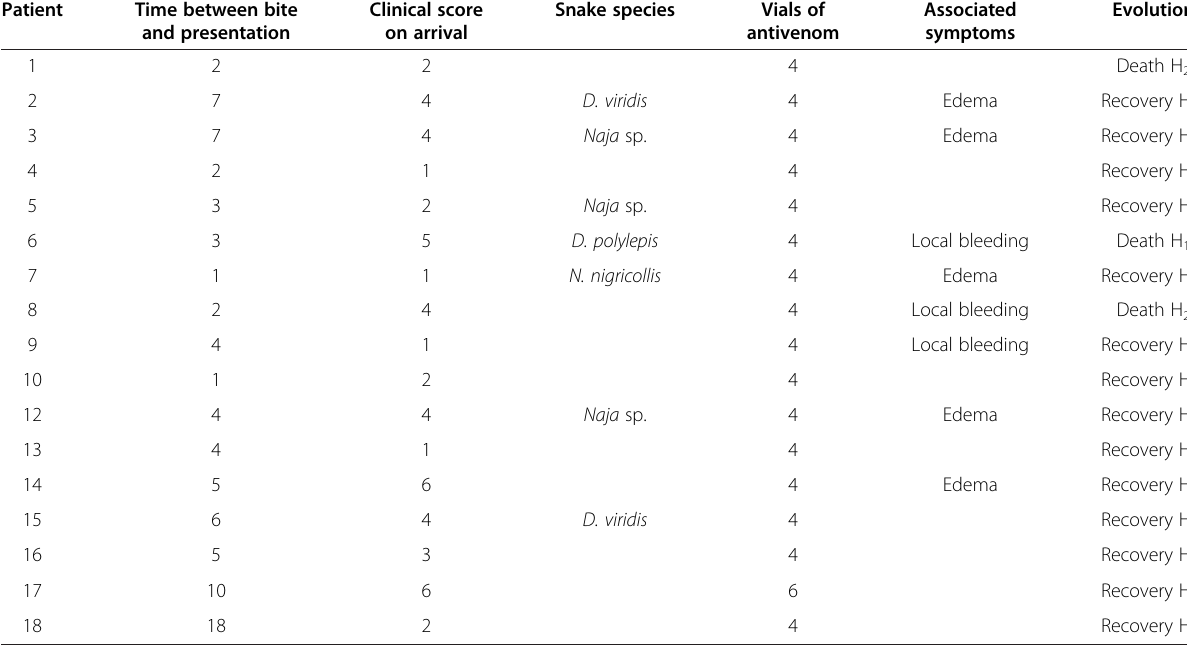
Table 4 Symptoms and time to death in patients of group 3 (high dose of antivenom); one death (#11) was not recorded because the patient died before treatment, less than three hours after the bite Patient Time between bite Clinical score Snake species and presentation on arrival